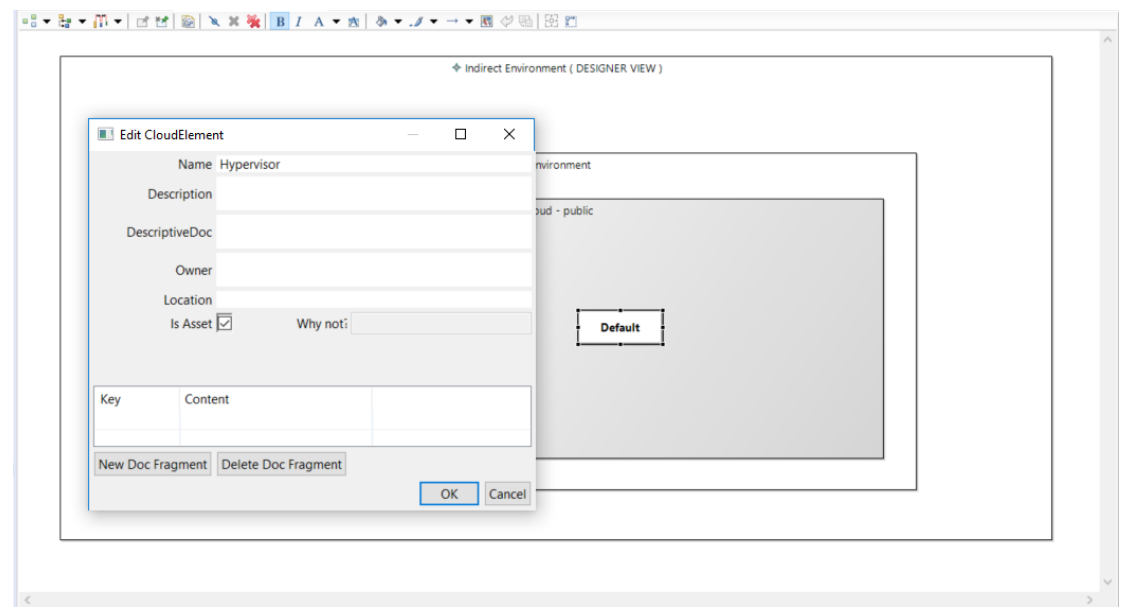
Figure 7. Adding a cloud element and defining its name.